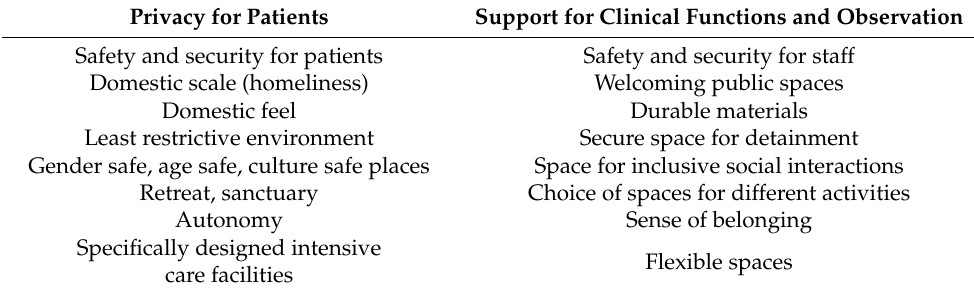
Table 3. The list of needs that the facility design must accommodate [10]. Privacy for Patients Support for Clinical Functions and Observation Safety and security for patients Safety and security for staff Domestic scale (homeliness) Welcoming public spaces Domestic feel Durable materials Least restrictive environment Secure space for detainment Gender safe, age safe, culture safe places Space for inclusive social interactions Retreat, sanctuary Choice of spaces for different activities Autonomy Sense of belonging Specifically designed intensive care